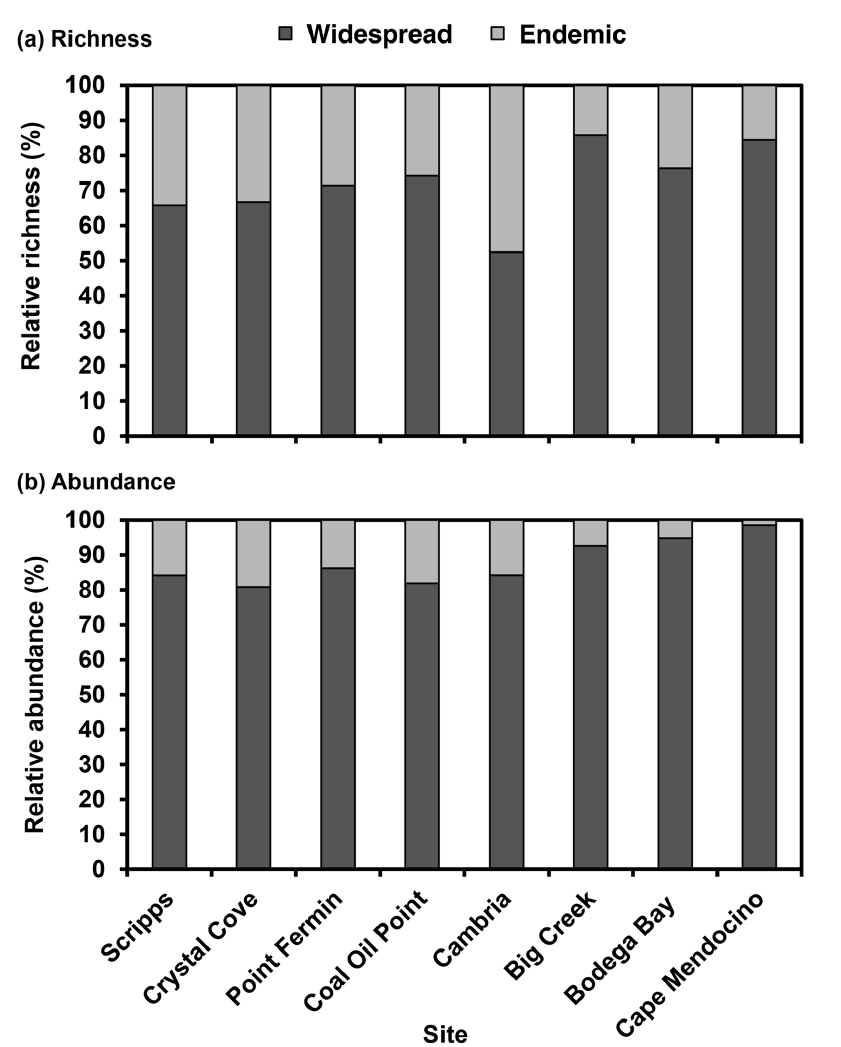
Figure 3. Relative species richness and abundance. (a) The majority of species were widespread species; on average, narrow-range endemic richness across sites made up less than 30% of total richness. (b) Narrow-range endemic species made up 20% or less of the total abundance at each